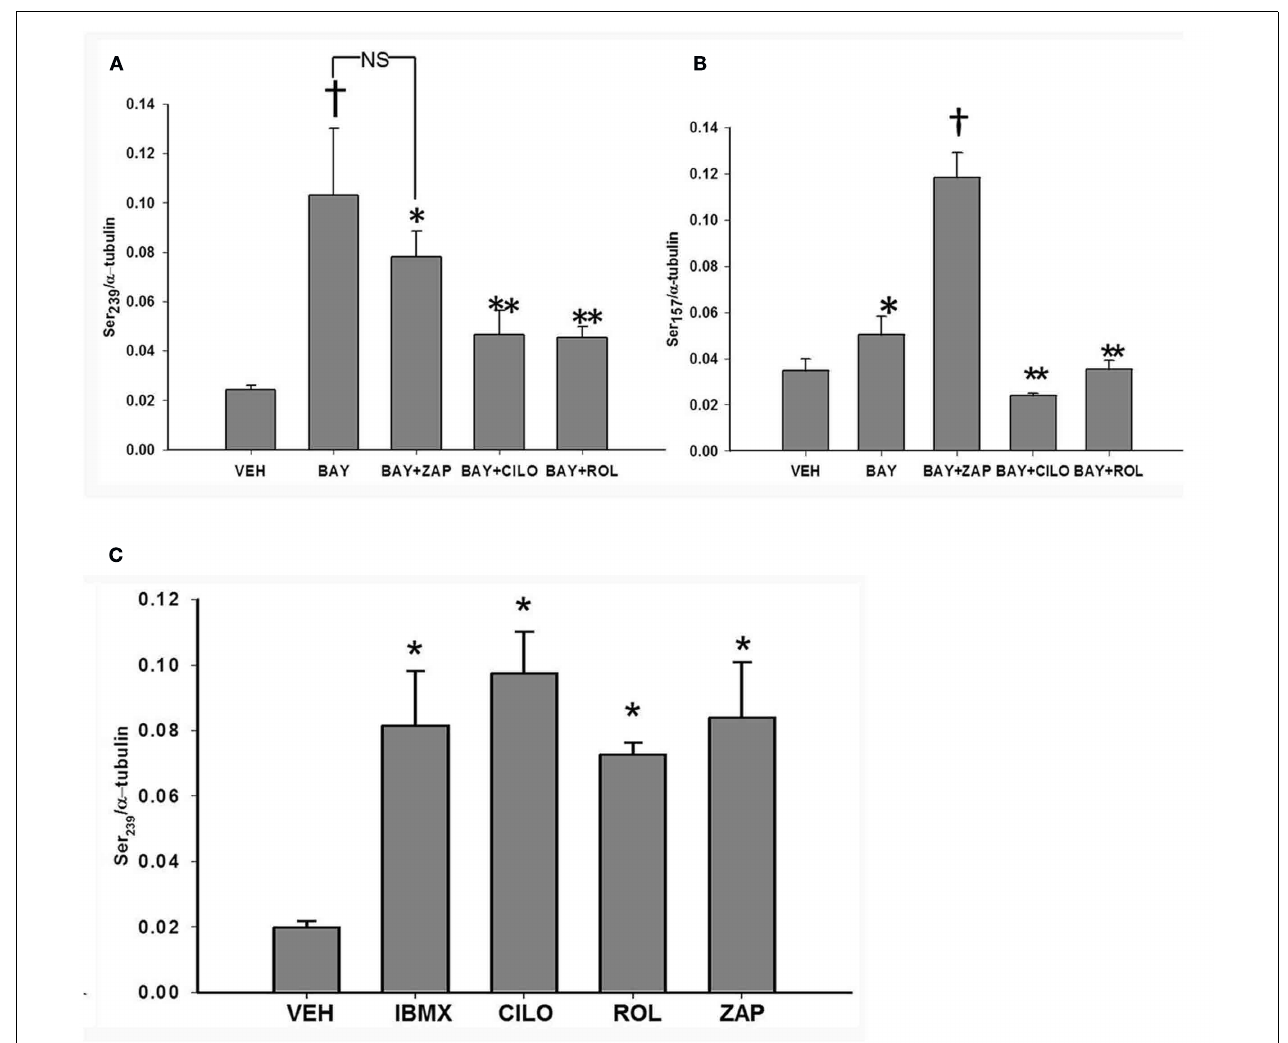
FIGURE 6 | (A) Effect of inhibitors of PDEs onVASPSer 239 phosphorylation.VSMCs treated with vehicle (DMSO), cilostazol (CILO, 10 μ M), rolipram (ROL, 10 μ M), or zaprinast (ZAP, 10 μ M) for 30min ( n = 5).Values are the means ± SE. *Different from vehicle control ( P < 0.05); **different from vehicle control and BAY ( P < 0.05); † different from all other values ( P < 0.05). (B) Effect of inhibitors of PDEs on BAY 41-2272 (BAY)-inducedVASPSer 157 phosphorylation.VSMCs treated with BAY (10 μ M) in the absence or presence of cilostazol (CILO, 10 μ M),